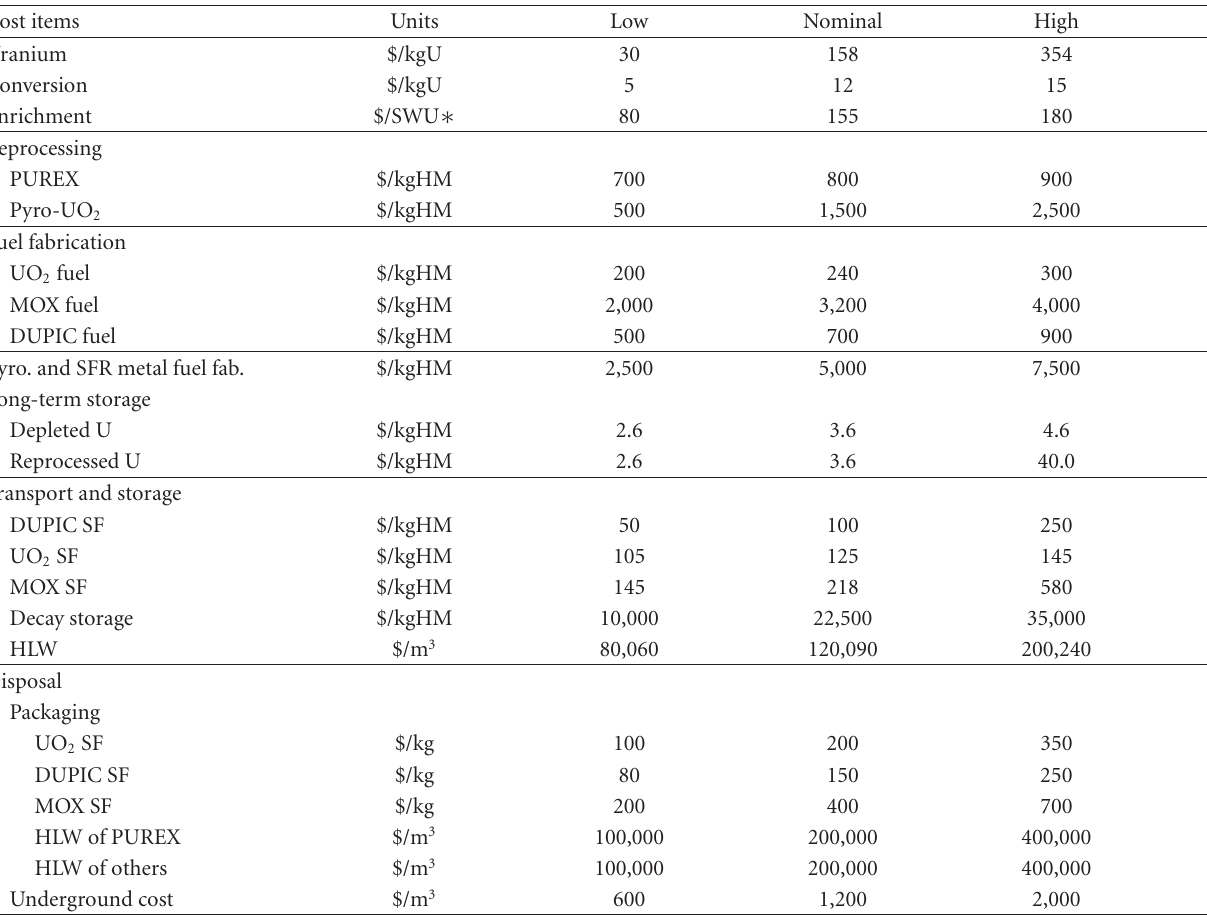
Table 1: Unit costs for nuclear fuel cycle steps.